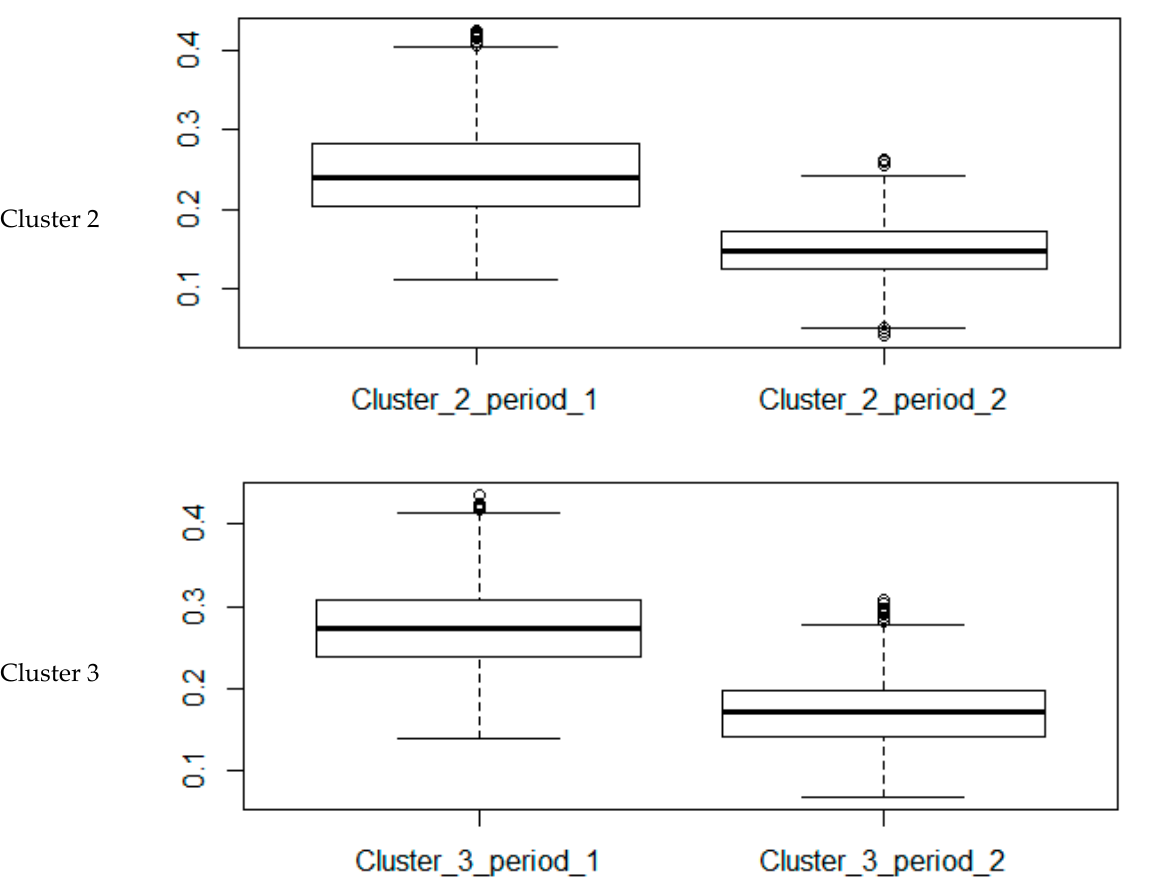
Figure 12. Box plots of voltage unbalance factor k u2 comparing periods for individual clusters in each phase.